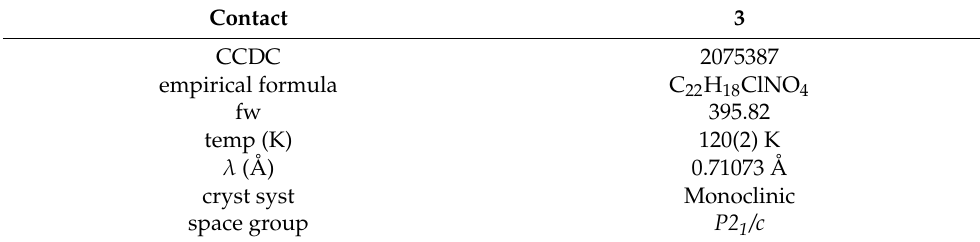
Table 1. Crystal data and structure refinement for 3